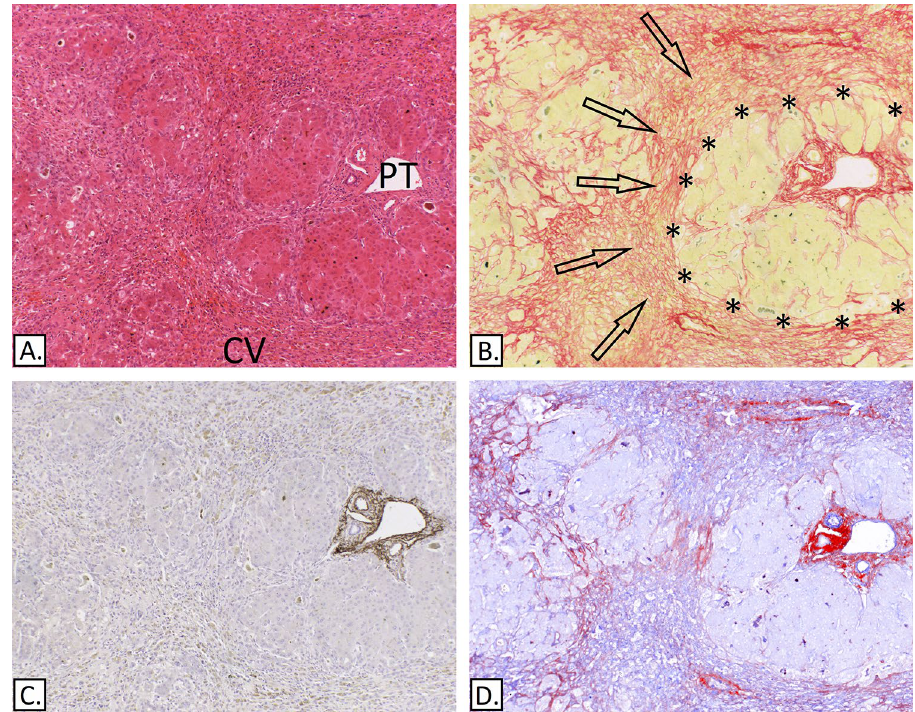
Figure 4. Liver from a patient with a paracetamol overdose. ( A ) H&E. The portal tract (PT) and centrilobular hepatic venule (CV) are labelled. ( B ) picro-Sirius red, arrows mark the mid-centrilobular ECM and asterisk the nodular configuration of the hepatocytes. ( C ) IHC-Elastin (ab9519). ( D ) IHC-collagen I (ab6308) in red & collagen III (ab7778) in blue, spectrally unmixed channels from Nuance camera + software. The hepatocytes show a somewhat nodular configuration suggesting an attempt at regeneration demarcated by the asterisks in B. There is condensation of the intervening ECM framework, predominantly collagen III (D.) marked by the